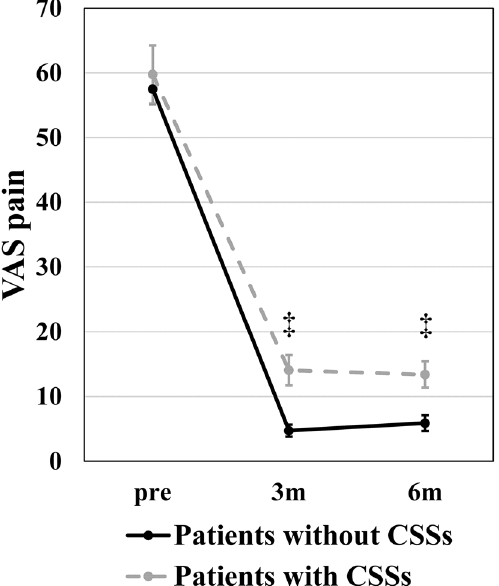
Figure 2. VAS pain scores at 1 month before, and 3 and 6 months after total hip arthroplasty in patients with and without CSSs. ‡ P < 0.001. VAS visual analog scale, CSS central sensitivity syndrome, Pre 1 month before surgery, 3m 3 months after surgery, 6m 6 months after